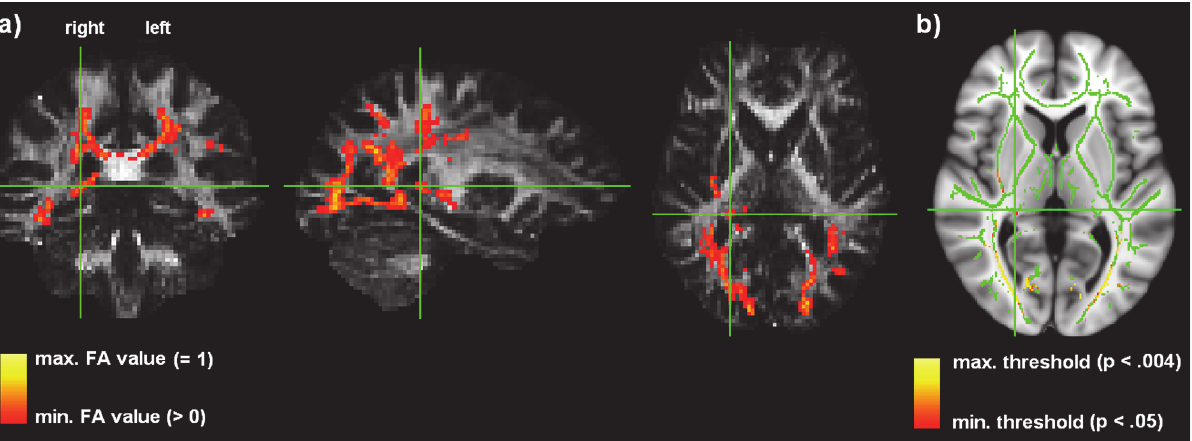
Fig 2. Back-projection to the space of the native data in FA exemplified by a sighted individual (174, see Table 1) (a). In order to obtain an individual ’ s exact FA value (used for post hoc correlation), the subject ’ s native anatomy was loaded to find the correct voxel, e.g. the region close to thalamus/Pv (yellow: max. FA = 1; red: min. FA > 0, red), according to (b) the location of the significant cluster resulting from the group comparison (yellow: p < 0.004; red: p <